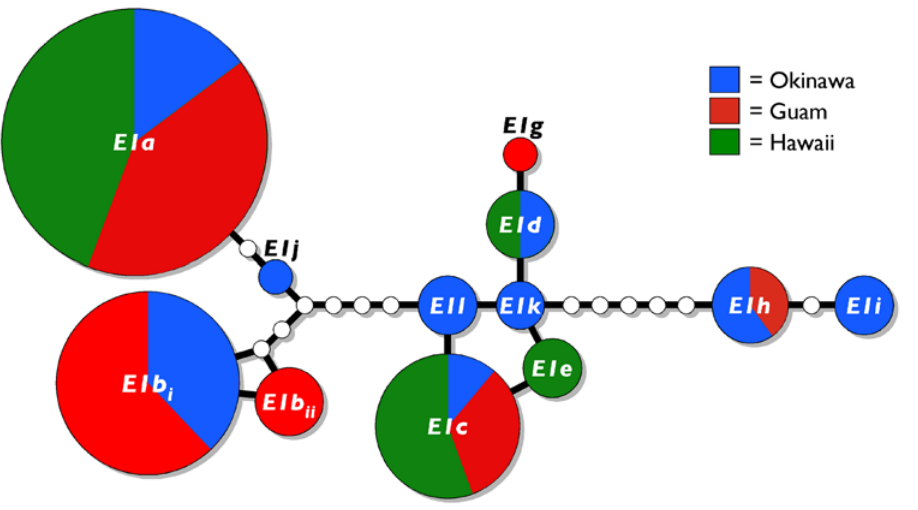
Figure 1. Haplotype network of alleles of conotoxin locus E1 of Conusebraeus at Guam and Hawaii. Haplotypes are illustrated as circles; hypothetical haplotypes that were not observed are illustrated as small, empty circles. Areas of circles are proportional to frequencies of alleles; pie diagrams illustrate the allelic frequencies at each location.